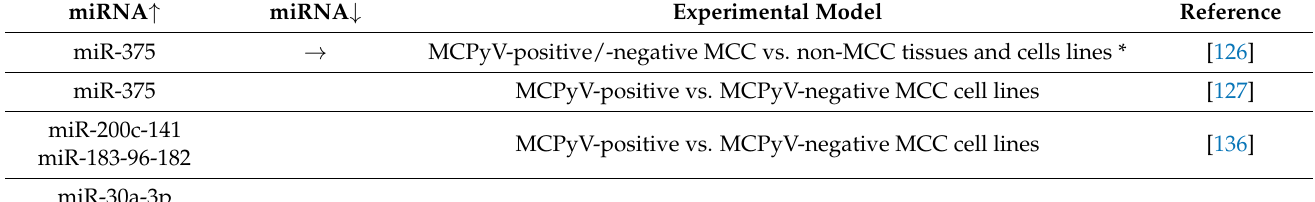
Table 3. Differentially expressed miRNAs in Merkel cell polyomavirus (MCPyV)-positive Merkel cell carcinoma (MCC) tissues and/or MCPyV-positive MCC-derived cell lines. miRNA ↑ miRNA